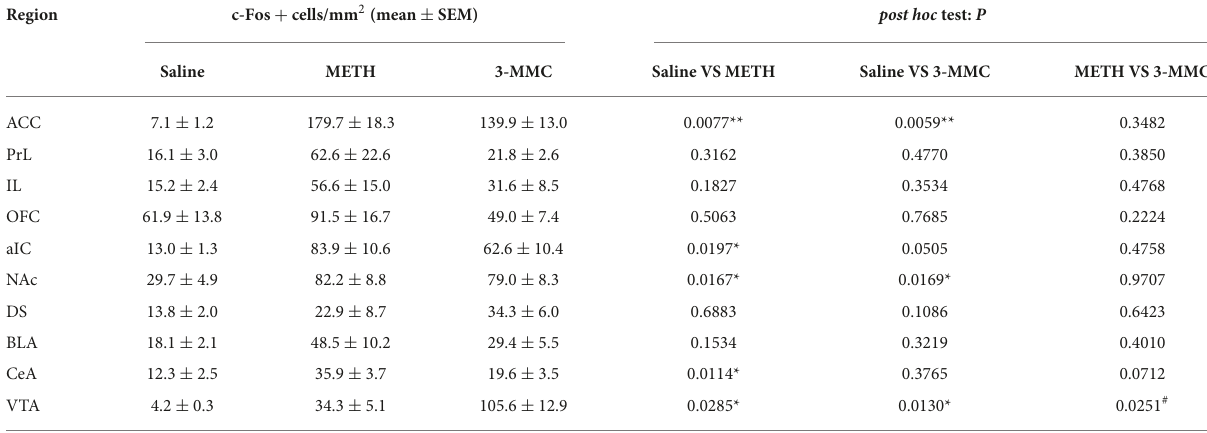
TABLE 1 The c-Fos expression patterns in each brain region after chronic injection of saline, methamphetamine (METH) and 3-MMC. Region c-Fos + cells/mm 2 (mean ± SEM) post hoc test: P